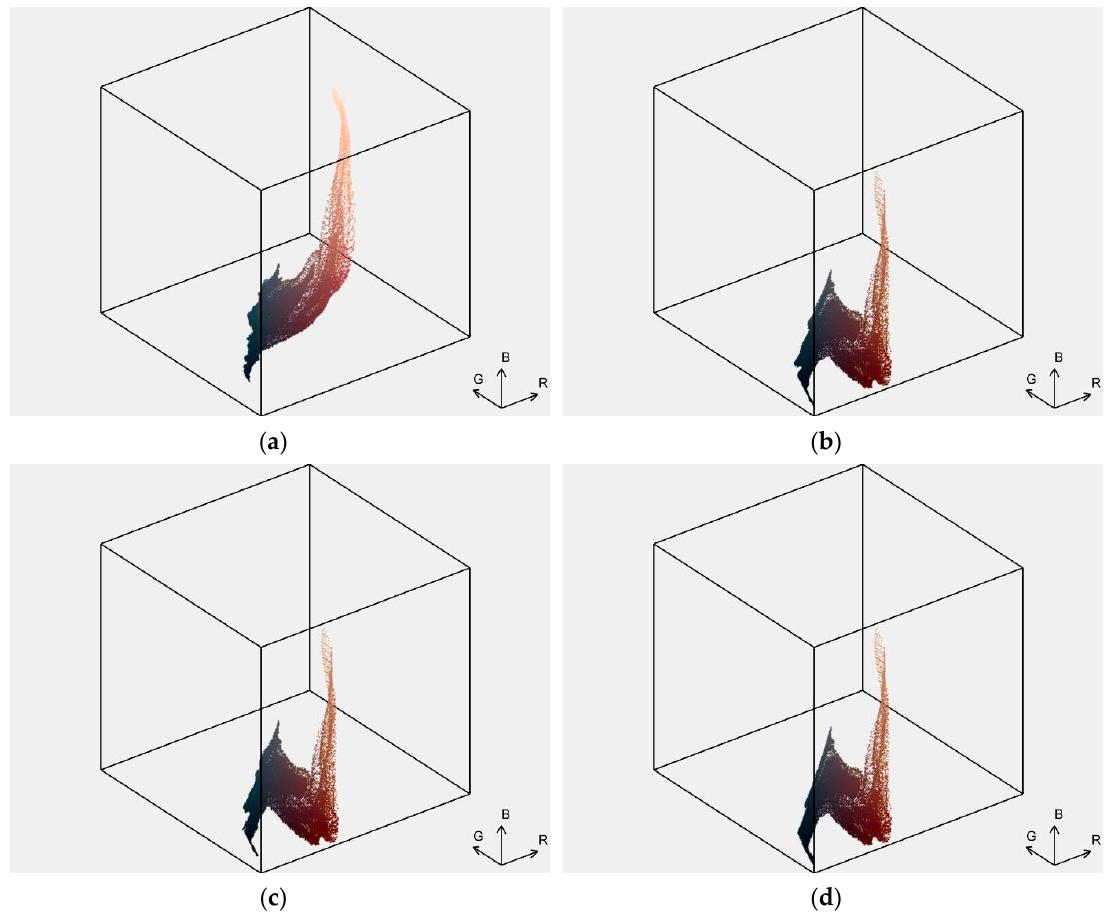
Figure 6. Color clouds of pixel color distribution over the RGB color cube of the ( a ) original image of M87 in Figure 5a, ( b ) 22 nd ISED-generated image in Figure 5b, ( c ) 23 rd ISED-generated image in Figure 5c, and ( d ) 24 th ISED-generated image in Figure 5d.